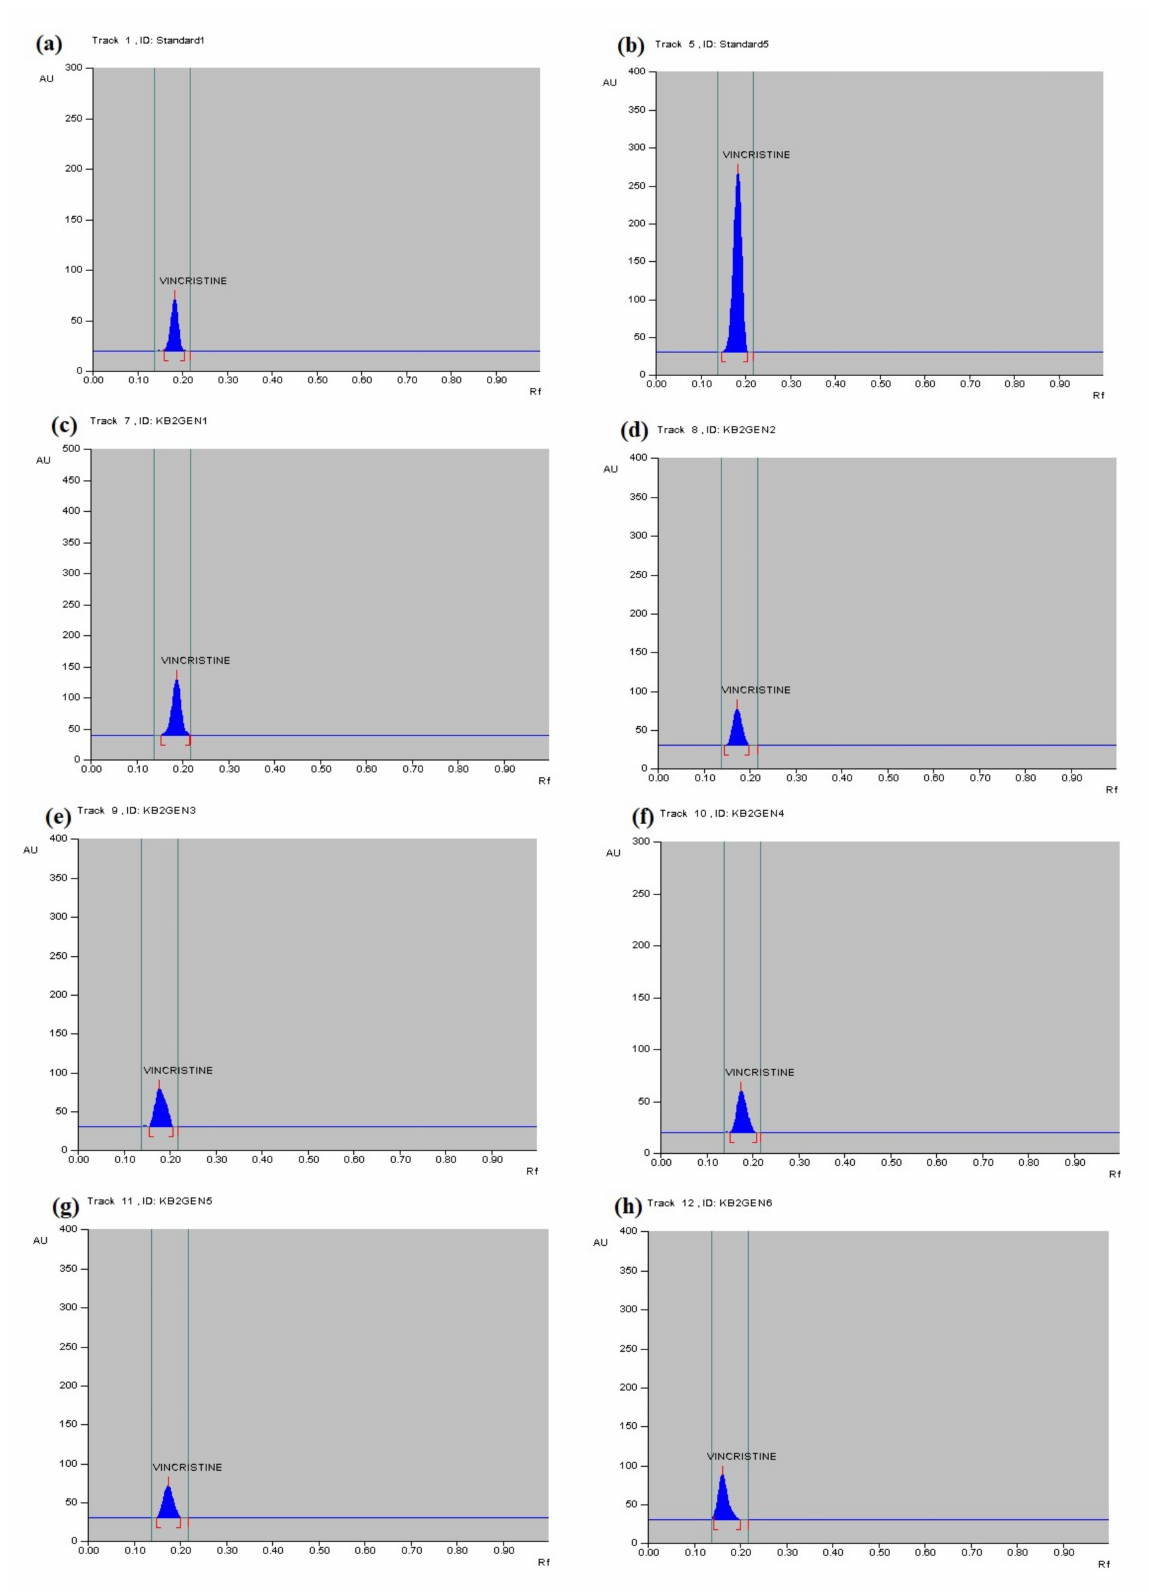
Figure 4. HPTLC peaks for vincristine, showing ( a ) standard at 200 ng/mL; ( b ) standard at 1 mg/mL; ( c ) generation 1 at 300 ng/mL; ( d ) generation 2 at 300 ng/mL; ( e ) generation 3 at 300 ng/mL; ( f ) generation 4 at 300 ng/mL; ( g ) generation 5 at 300 ng/mL; and ( h ) generation 6 at 300